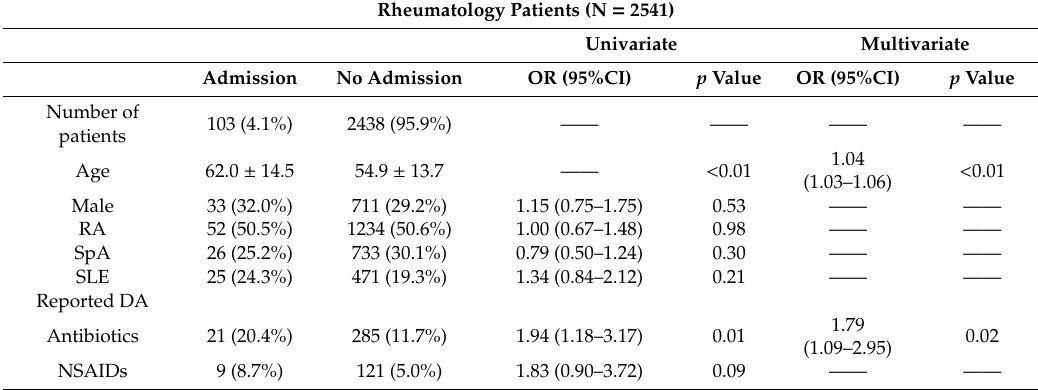
Table 3. Association analysis between clinical features and infection-related hospitalization.